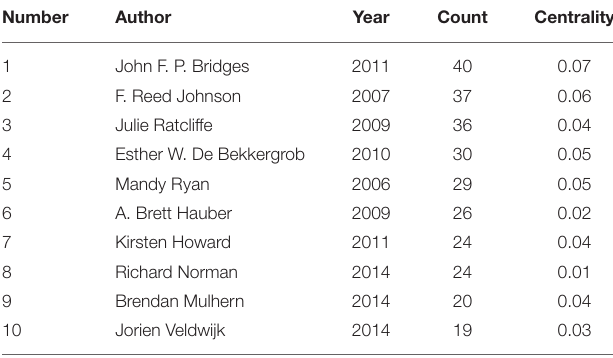
TABLE 1 | The top 10